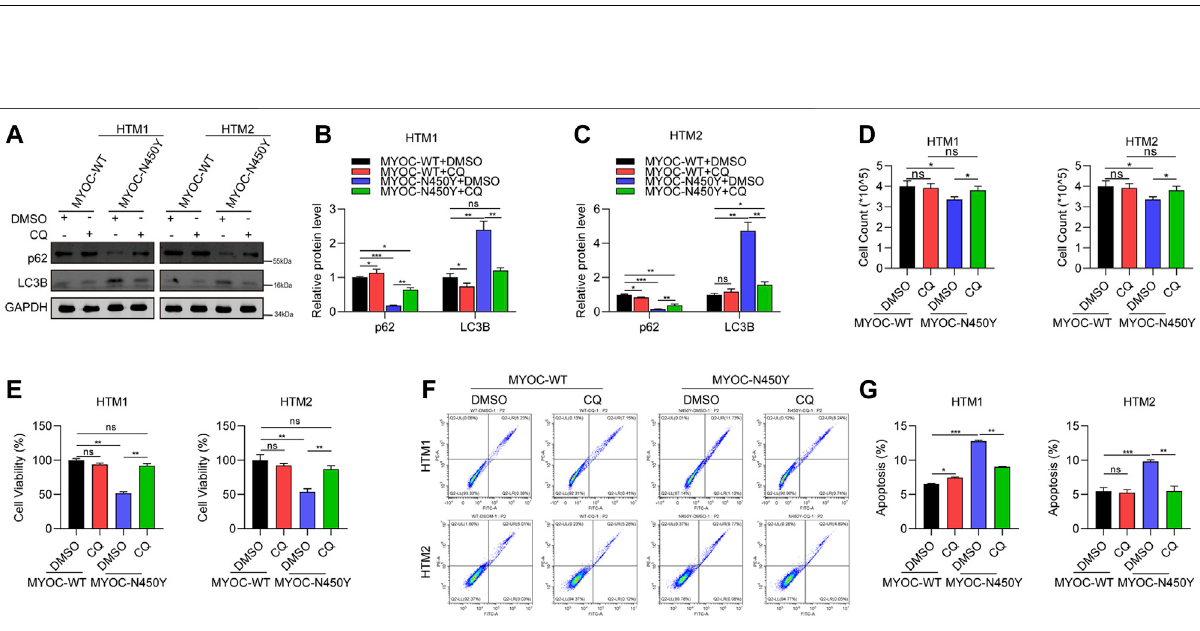
Frontiers in Cell and Developmental Biology |